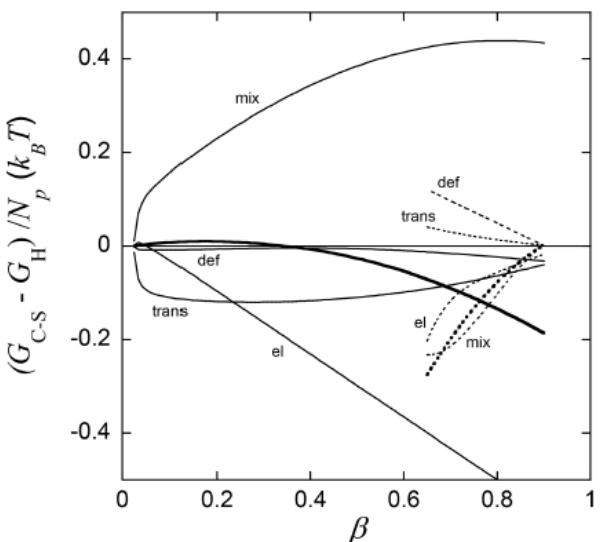
Figure 20. Theoretically calculated total difference in free energy (per polymer charge) between core−shell and homogeneous states (thick curves) plotted vs. the surfactant/polymer charge ratio β (y = 0). Shown are also the contributions to the difference from the free energy of mixing (mix), electrostatic energy (el), elastic deformation energy (def), and free energy of transferring the hydrophobic tails from water to micelles (trans) (thin curves). Figure taken from ref. [22]. Reprinted with permission. Copyright 2017 American Chemical Society.